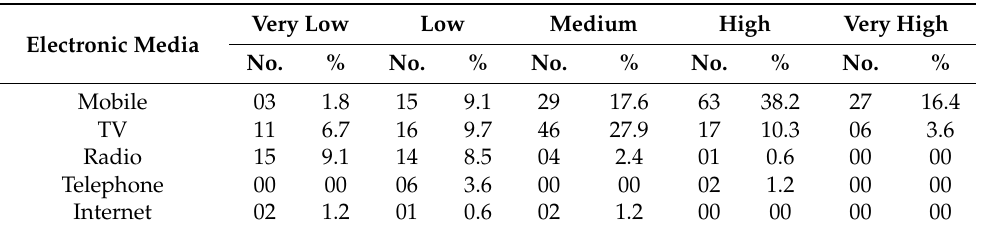
Table A1. No. of farmers and percentages of five Likert scale scores for the usefulness of electronic media as a source of information among dairy farmers.